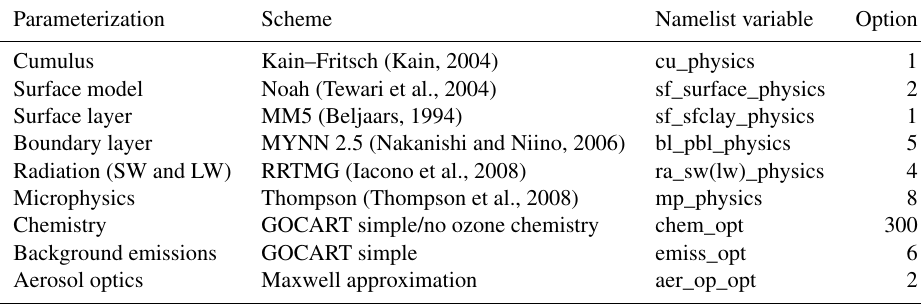
Table 4. WRF-Chem physics and chemistry parameterizations. Parameterization